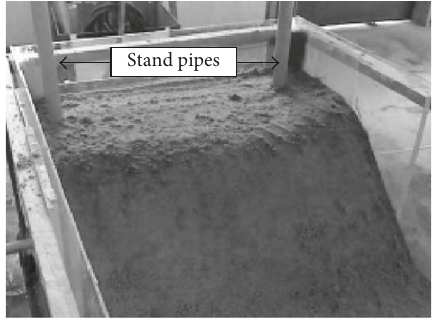
Figure 6: PVC stand pipes for water level observation.